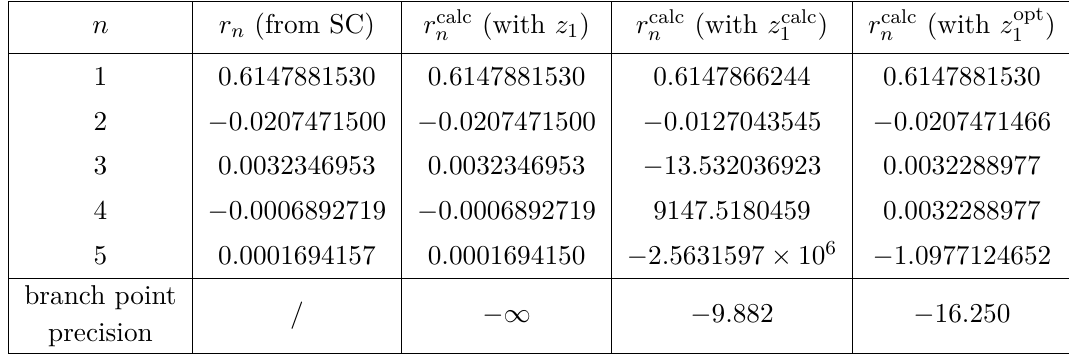
Table 1. The first 5 coefficients r n determining the odd coefficients b 2 n +1 of the expansion of f 1 ( z ) around z 1 . The first column displays the ‘exact’ values of r n computed directly (analytically) from the spectral curve (SC). The remaining three columns show the ‘reconstructed’ values of r n (using the algorithm in eq. (3.25)), computed by using the location of the critical point z 1 obtained in different ways: exact z 1 , reconstructed z calc (cf. eq. (4.8)), respectively. In the last line of the table, we state the error log branch point used in each respective